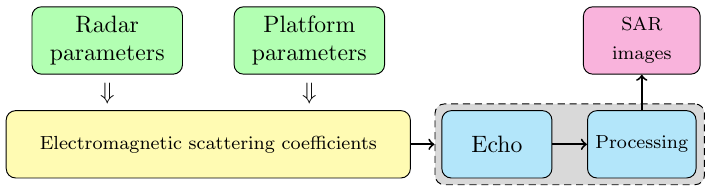
Figure 3. Process of SAR image simulation based on echo signal.